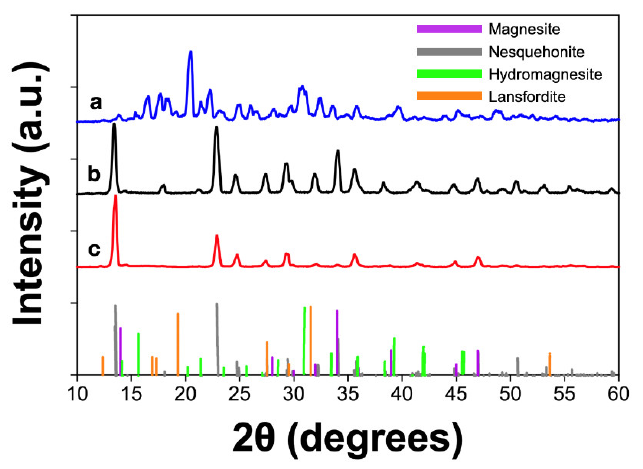
Figure 3. X-ray diffraction patterns of ( a ) DSA (dumbbell-shaped aggregates) product, ( b ) magnesium carbonate, from supercritical synthesis, hot plate dried, scCO 2 -hpd, and ( c ) magnesium carbonate from supercritical synthesis, oven dried, scCO 2 -od. Reference peaks of crystalline structures with the highest correlation are shown as determined by Rietveld refinement.